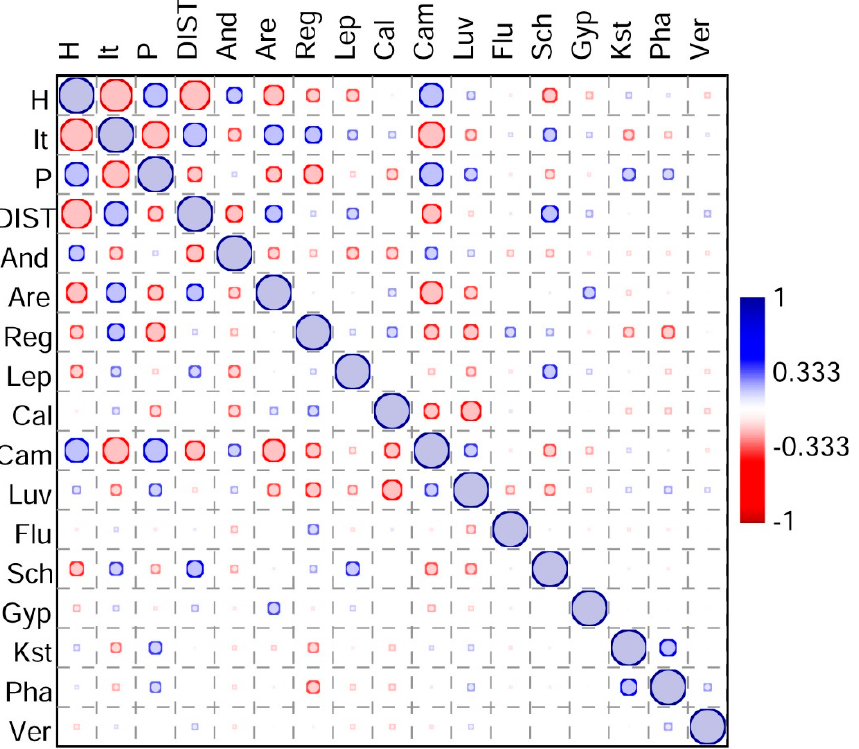
Figure 4. Correlation matrix of variables included in the PCA according to Pearson’s parametric test. The blue spectrum means positive correlations, while the red one means negative correlations.